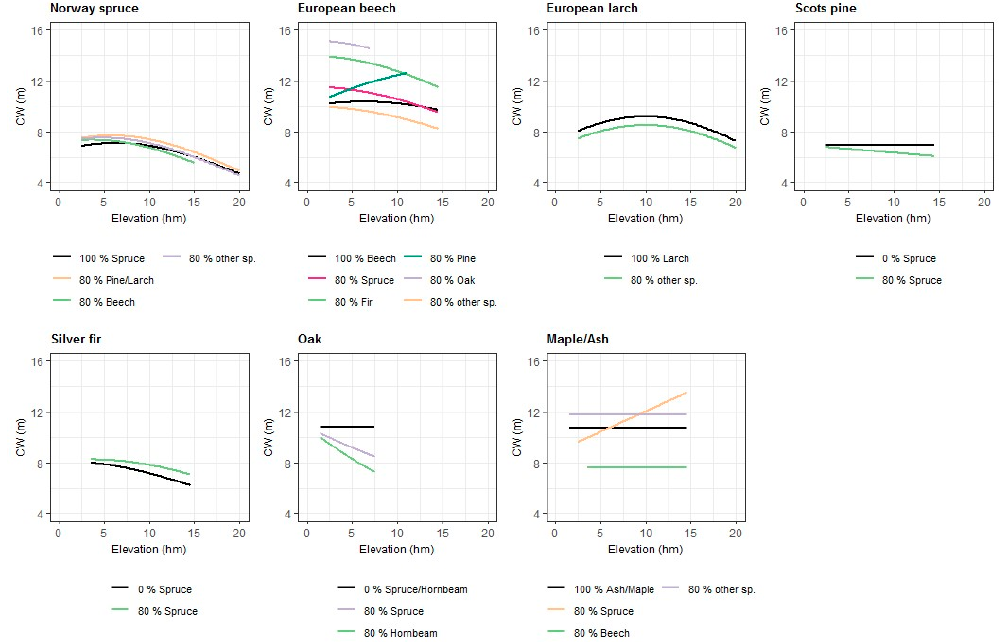
Figure 2. Effects of elevation (hectometre) and species composition in the stand (described by PS_x or PSL_x) on the CW (m) for different tree species. The figures were produced using the parameter estimates for the fixed effects in Tables 3 and 4. For the DBH, a value of 50 cm was assumed. For other variables, which are not shown in this figure, the mean values of the observed data were used.